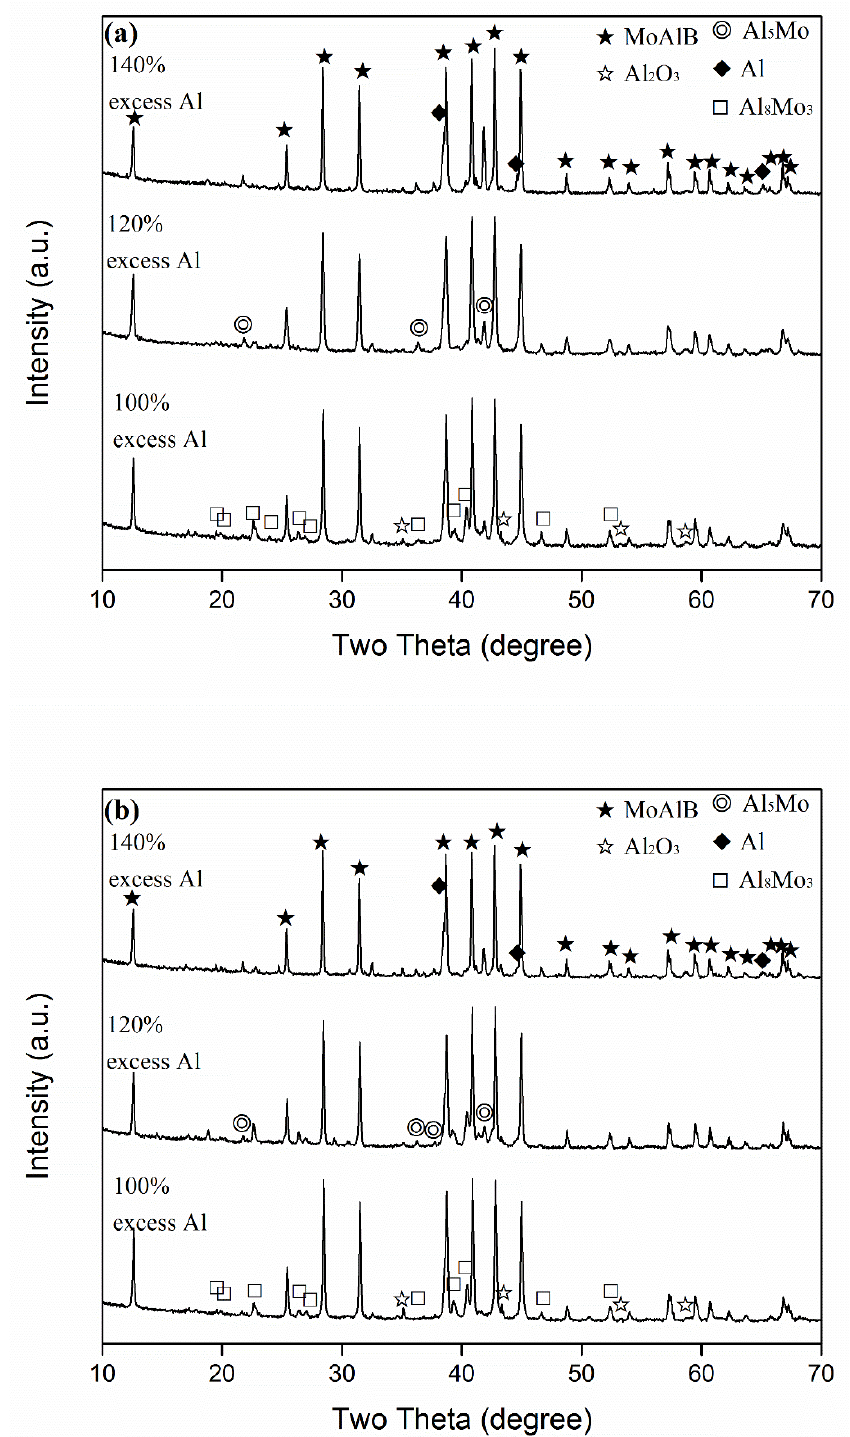
Figure 3. XRD patterns of the samples with various amounts of excess Al, after 6 h of firing at ( a ) 900 and ( b ) 950 °C, separately.